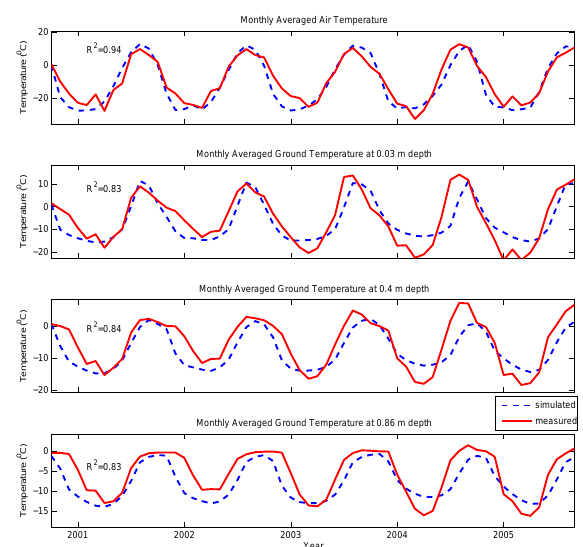
Fig. 3. Measured (solid) and calculated (dashed) monthly averaged temperatures at 2m above the ground and 0.03, 0.4 and 0.86m depth for SagMat 69.43 ◦ N, − 148.70 ◦ W permafrost observation station.